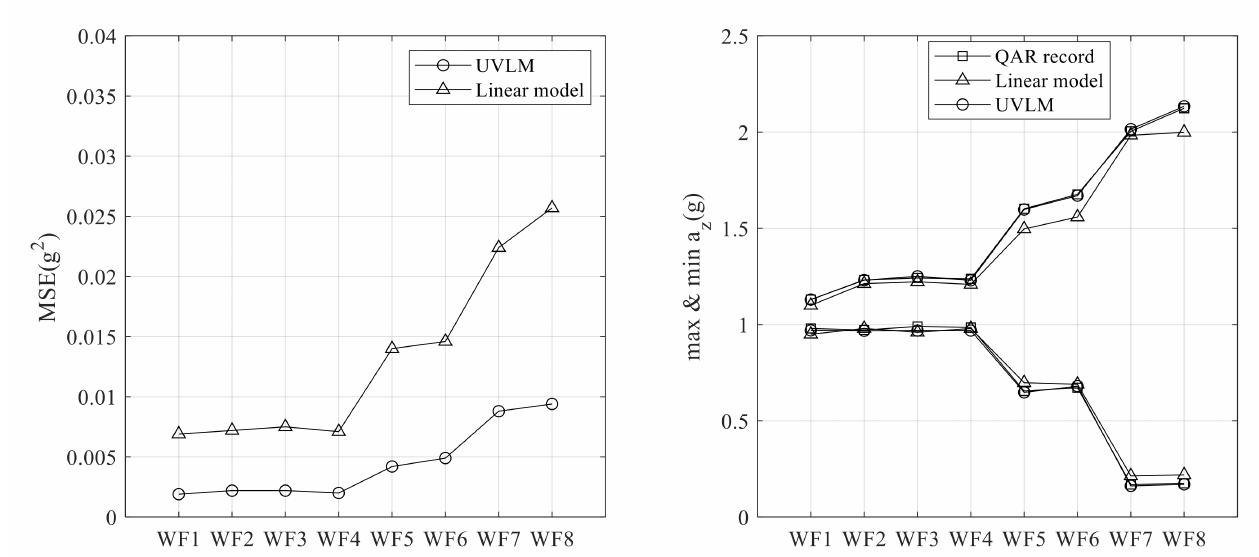
Figure 11. Mean Square Error (MSE) and Peak value of